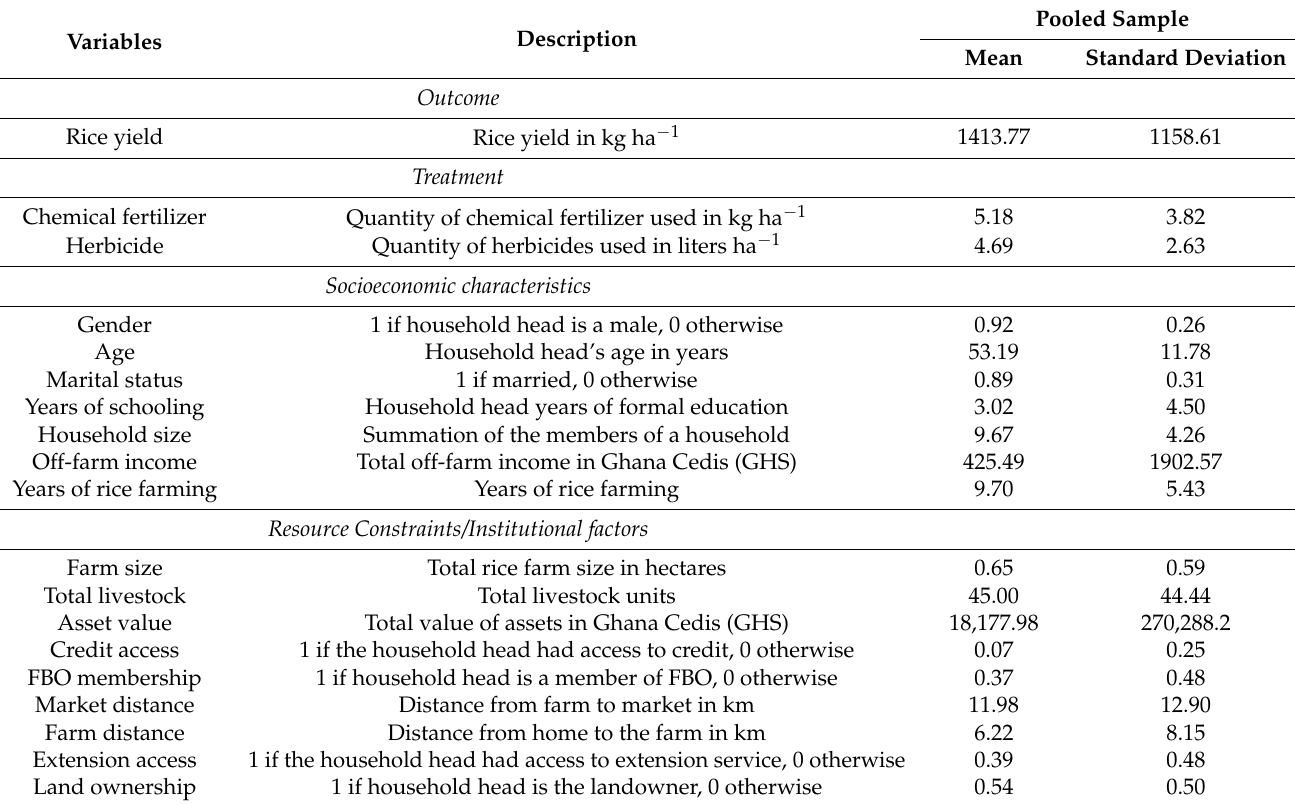
Table 1. Definition and summary statistics of the pooled sample.